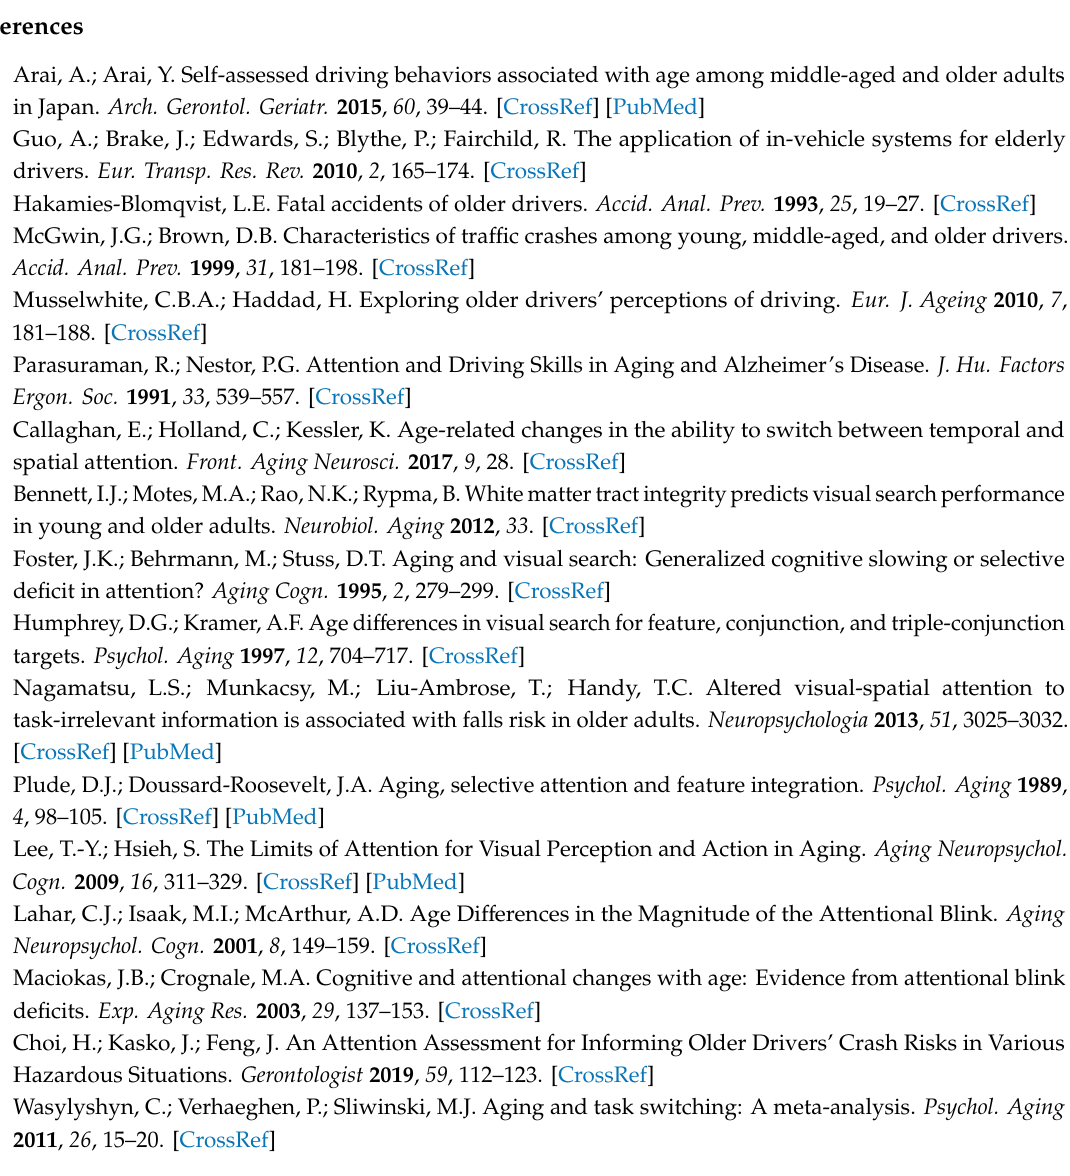
Table S1: Counterbalanced Conditions; Figure S1: Group means of participants’ median braking RTs; Figure S2: Group means of participants’ driving speeds when they passed the road sign; Figure S3: TFR in which time-frequency tiles for exploratory source analysis were selected, presenting power di ff erence from a baseline period of − 5.50 s– − 3.50 s averaged across 12 anterior electrodes and across all conditions and all age groups; Figure S4: TFRs present power in relation to a baseline period of − 5.50 s– − 3.50 s averaged across a group of posterior electrodes; Figure S5: TFRs present power in relation to a baseline period of − 5.50 s– − 3.50 s in all electrodes that were included in the analysis; Indicator RT statistics in EEG